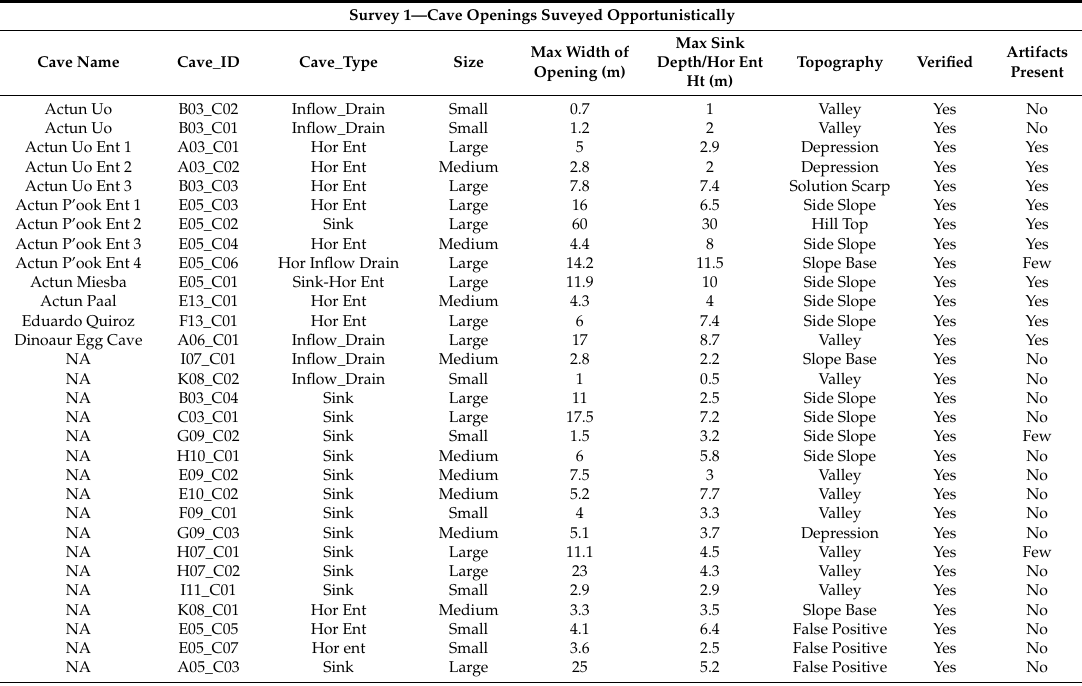
Table 1. Caves located in Survey 1 and Survey 2, and four previously known